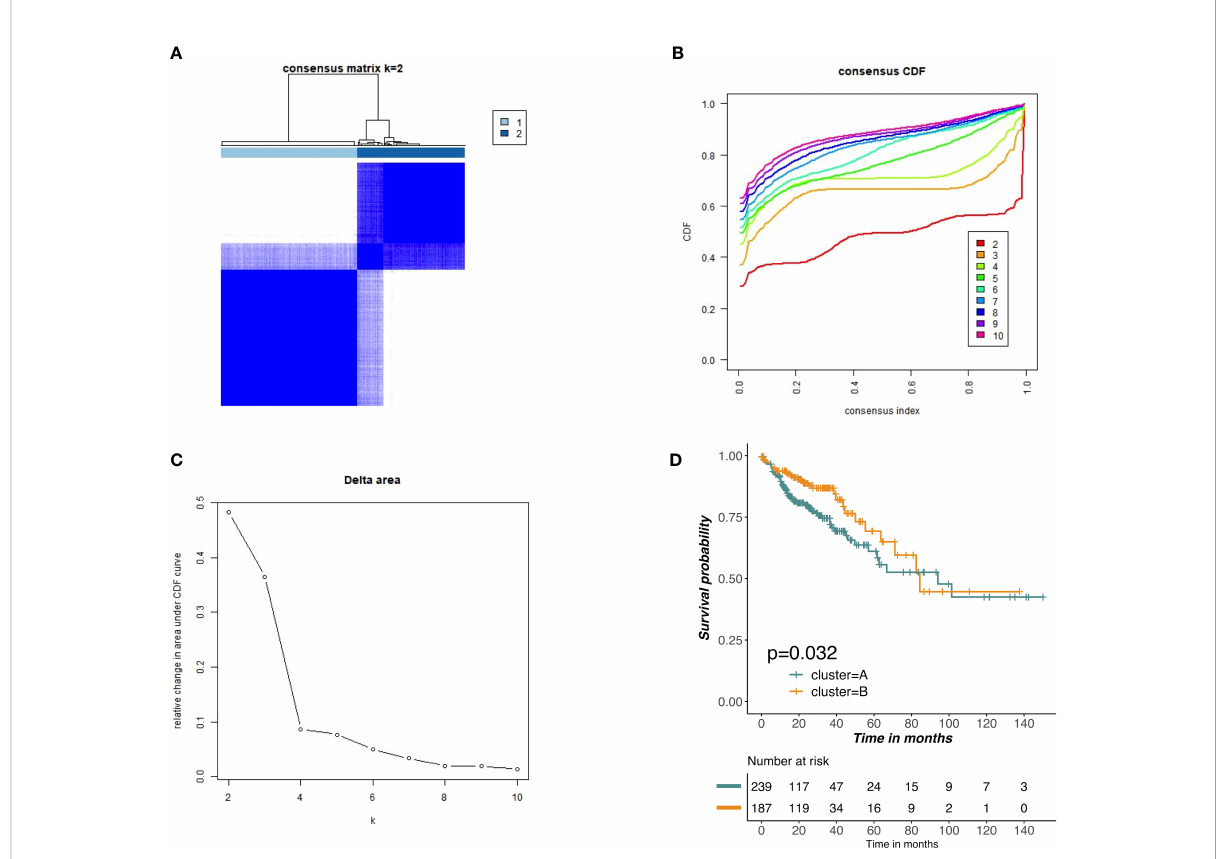
FIGURE 4 Unsupervised clustering of prognostic m6A-related lncRNAs. (A – C) Consensus clustering identi fi ed two main tumors clusters based on the expression of m6A-related lncRNA. (D) KM curves of OS for two clusters in COAD.